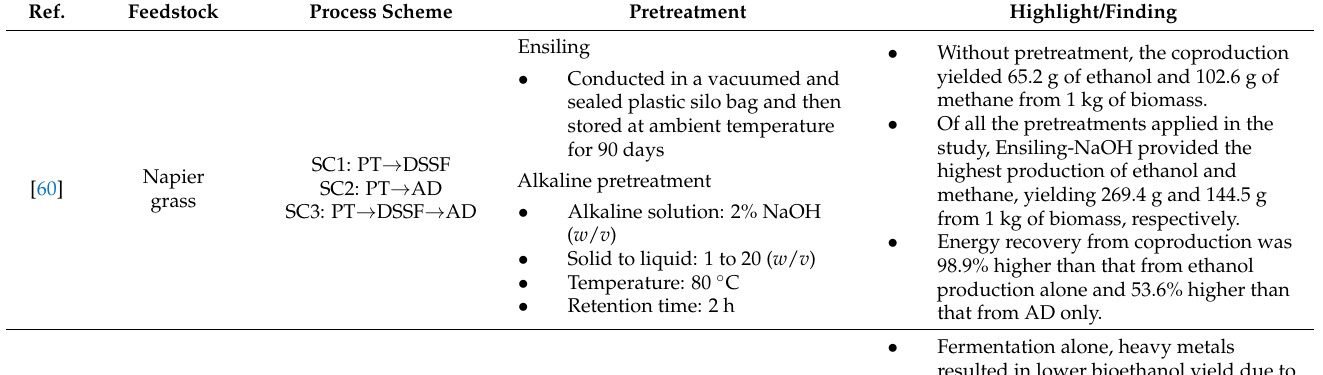
Table 1. Summary of studies on co-production of bioethanol and biogas from cellulosic biomass.